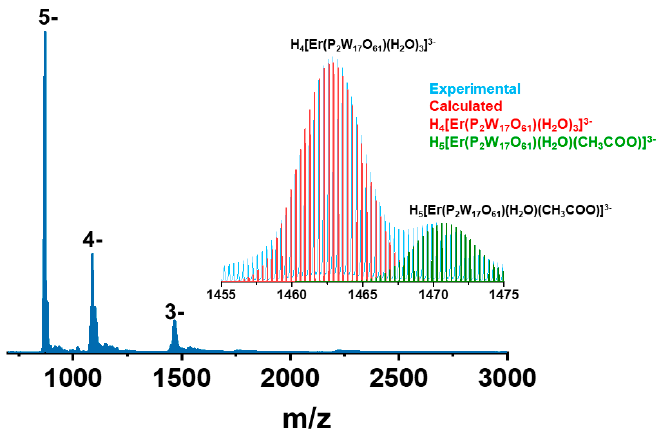
Figure 3. Negative ion electrospray ionization mass spectrometry (ESI MS) of 1 in a water / ACN mixture. The 3- region is expanded in the inset and two peaks are compared with their calculated isotope pattern.